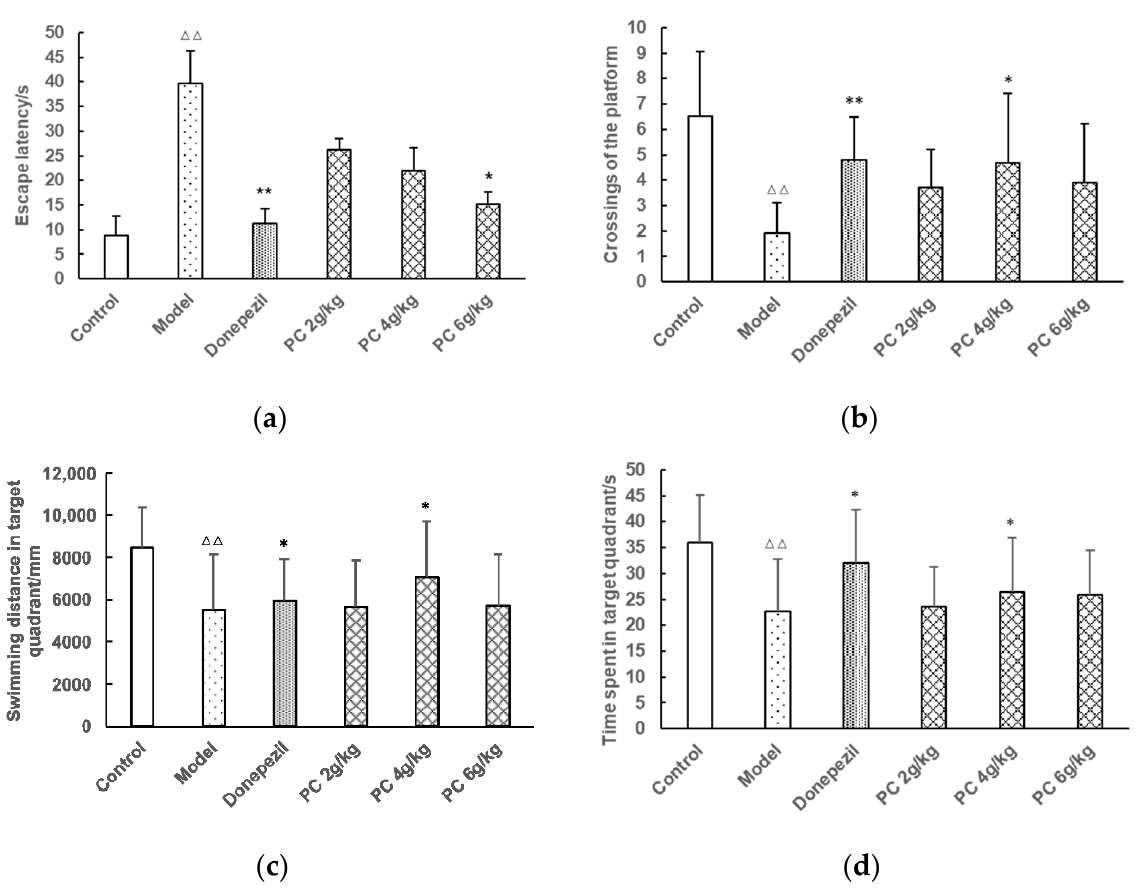
Figure 4. Mice’s performance in probe trials in the MWM (day 29). ( a ) escape latency, ( b ) crossings of the platform, ( c ) swimming distance in the target quadrant, and ( d ) the time spent in the target quadrant. A total of 60 qualified mice were randomly divided into six groups of 10 animals each, the control (0.5% CMC-Na solution, 0.2 mL/10 g), the model (0.5% CMC-Na solution, 0.2 mL/10 g), donepezil (3 mg/kg), and PC low- (2 g/kg), medium- (4 g/kg), and high- (6 g/kg) dose groups. All groups were administered daily i.g. for 28 consecutive days. The probe trials lasted 1 day after the acquisition (day29). The data represents the mean ± SD. (vs control: ∆∆ , p < 0.01; vs. model: *, p < 0.05, **, p < 0.01).